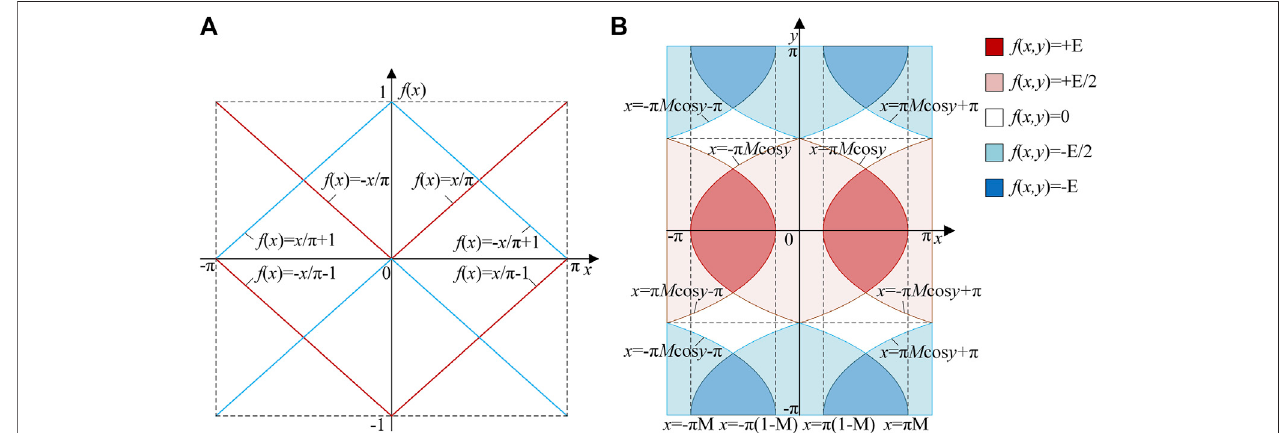
FIGURE 2 | Harmonic analysis of interleaved parallel PWM: (A) carrier waves, (B) the unit cell.